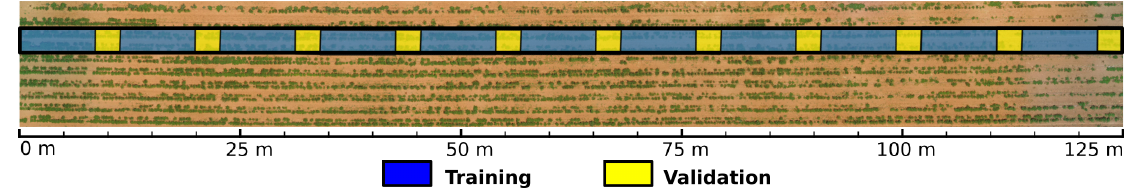
Figure 7. Training and validation